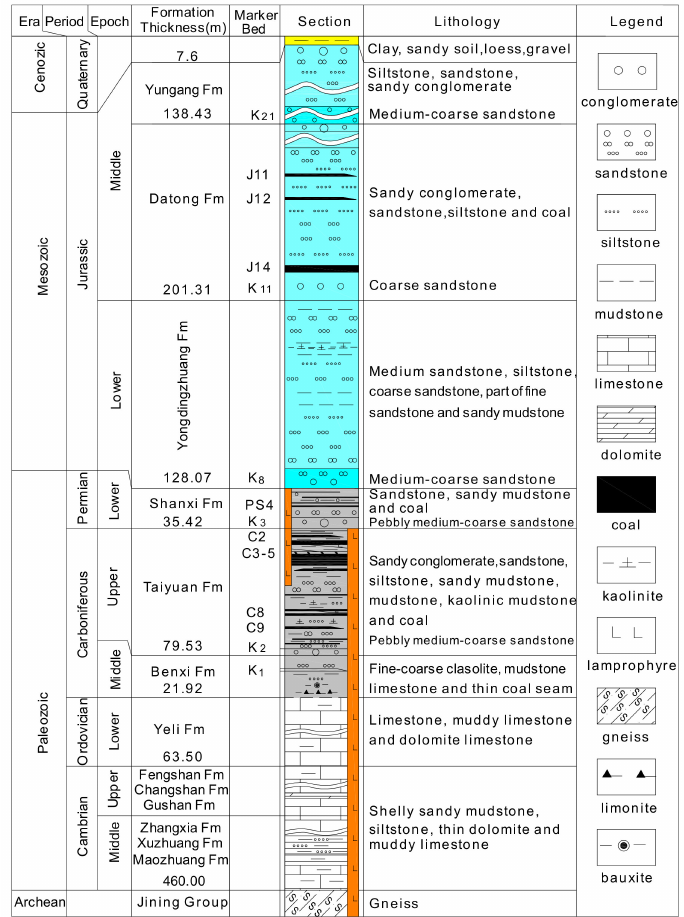
Figure 2. The stratigraphy of Kouquangou, Datong